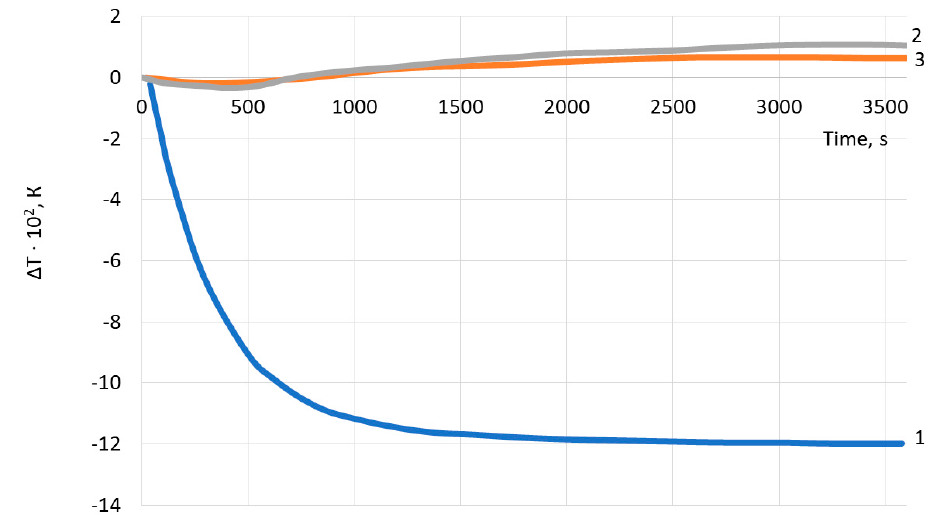
Figure 7. Dependence of the sandface temperature change vs. time for different compound: 1—oil + gas, 2—water + gas, 3—water.